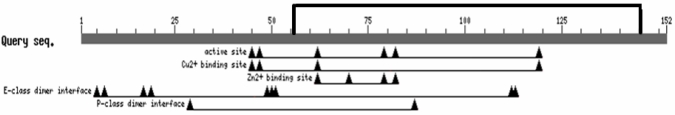
Nucleotide and deduce amino acid sequences of PS-CuZnSOD cDNA from P. sibiricum Laxm. The PCR products of PS-CuZnSOD cDNA were sequenced. The full length was 669 bp, with a 5′ untranslated region of 87 bp, a 3′ untranslated region of 123 bp and an open reading frame (ORF) encoding 152 amino acid (459 bp). The cDNA sequence of PS-CuZnSOD has been submitted to GenBank (accession No. GQ472846). The rectangle indicates the active site of the PS-CuZnSOD; ellipse indicates the Cu2+ binding site; * indicates the Zn2+ binding site; # indicates the stop codon. Two conserved CuZnSOD signatures are shown in broken line. The signal peptide is shown in solid line. Two cysteines (Cys56 and Cys145) form a disulfide bond for this gene.